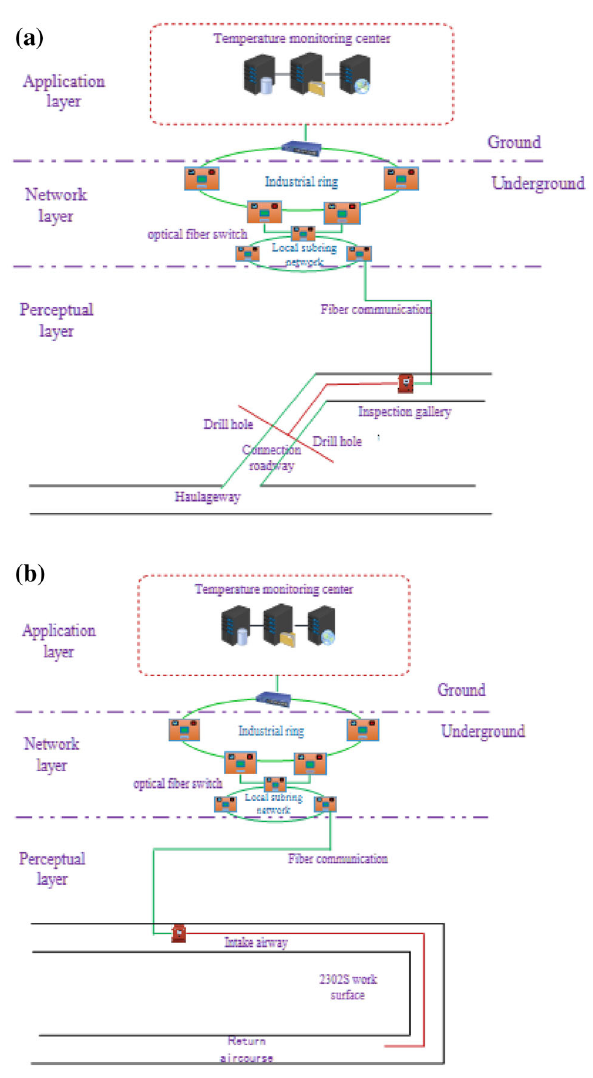
Fig. 2 Fiber optic temperature measurement system showing a rock temperature field measurement and b measurement of airflow temperature at the working